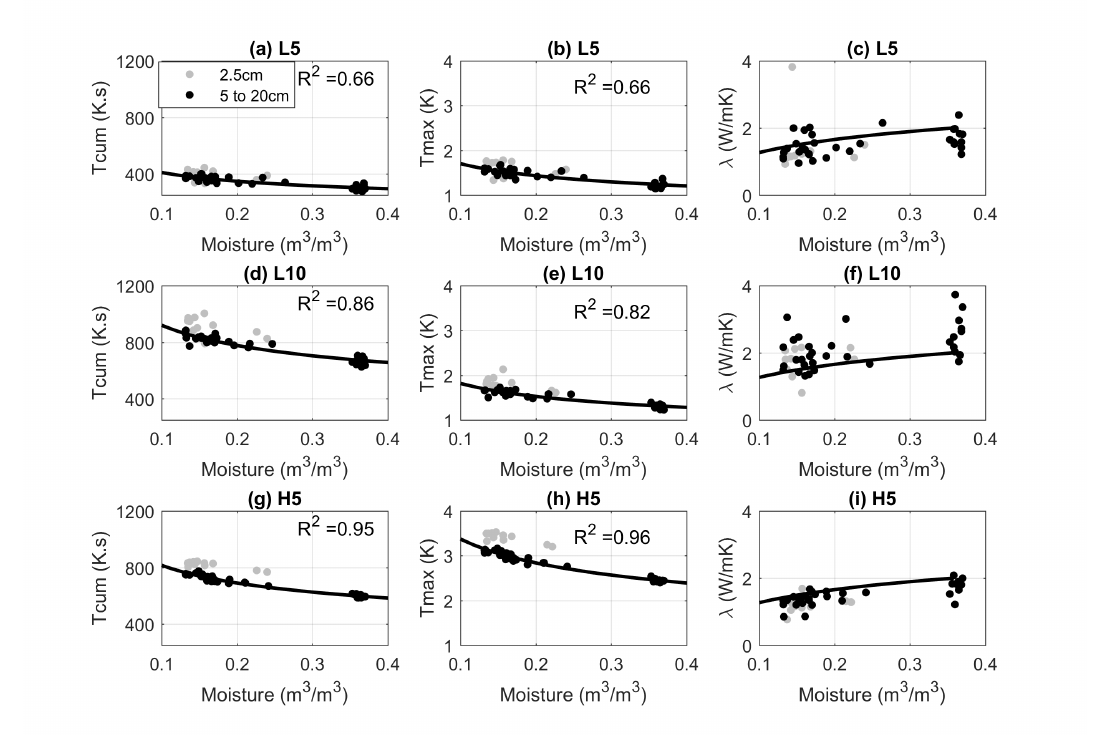
Figure 4. T cum (first column), T max (second column), and the estimated soil thermal conductivity ( λ ) (third column) as a function of EC5 measured soil moisture. The solid lines in the first two columns, are the fitted T cum and T max to soil moisture relationship, in which 2.5 cm measurements were not considered. The solid lines in the third column represents the measured soil thermal conductivity curve using KD2Pro heat-pulse sensor. Each plot represents heat pulse and soil moisture data collected from all four